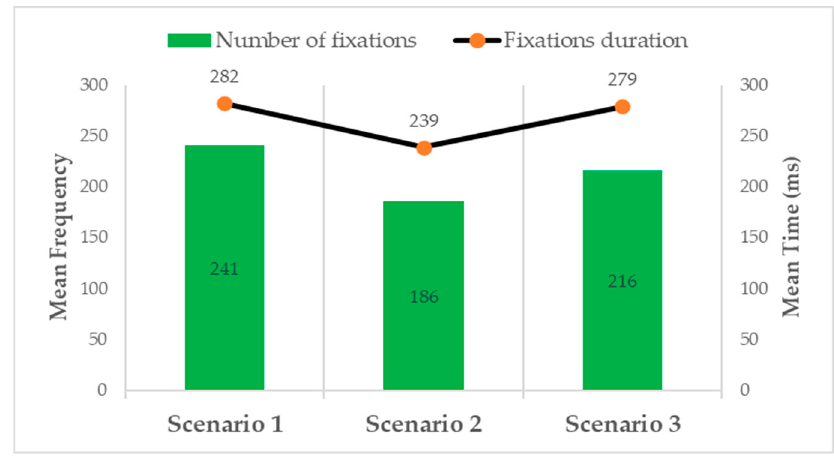
Figure 4. The number of fixations and fixation duration mean scores in the three trials.